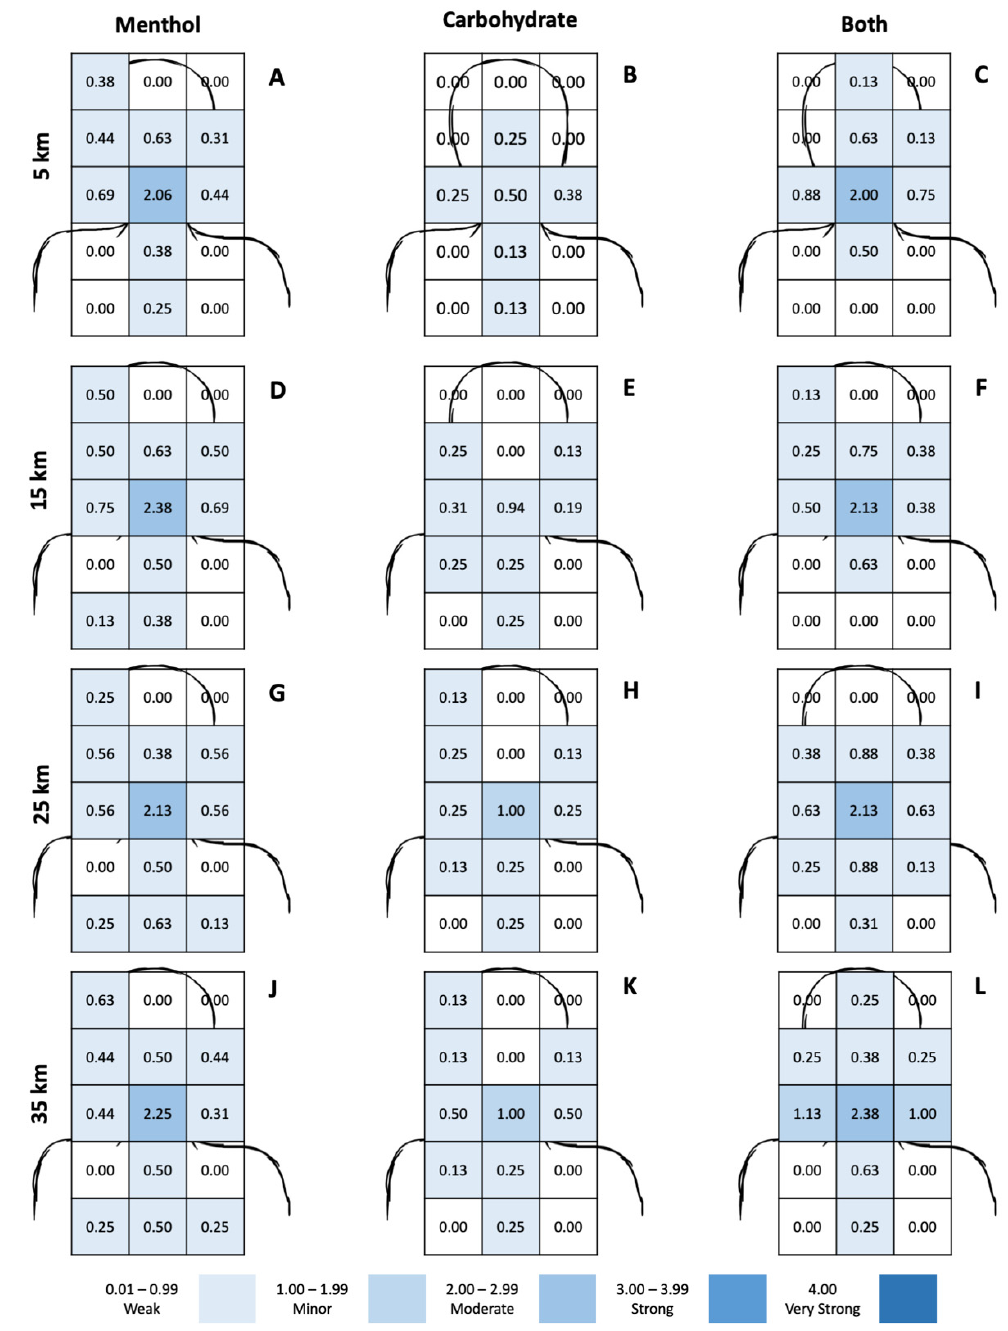
Figure 3. Location and intensity of oral cooling, by differing solutions. Columns are assigned to differing solutions: Panels ( A , D , G , J ) are for MEN; panels ( B , E , H , K ) are for CHO; panels ( C , F , I , L ) are for BOTH. Rows represent time points, 5 km ( A – C ), 15 km ( D – F ), 25 km ( G – I ) and 35 km ( J – L ) from top to bottom, respectively.